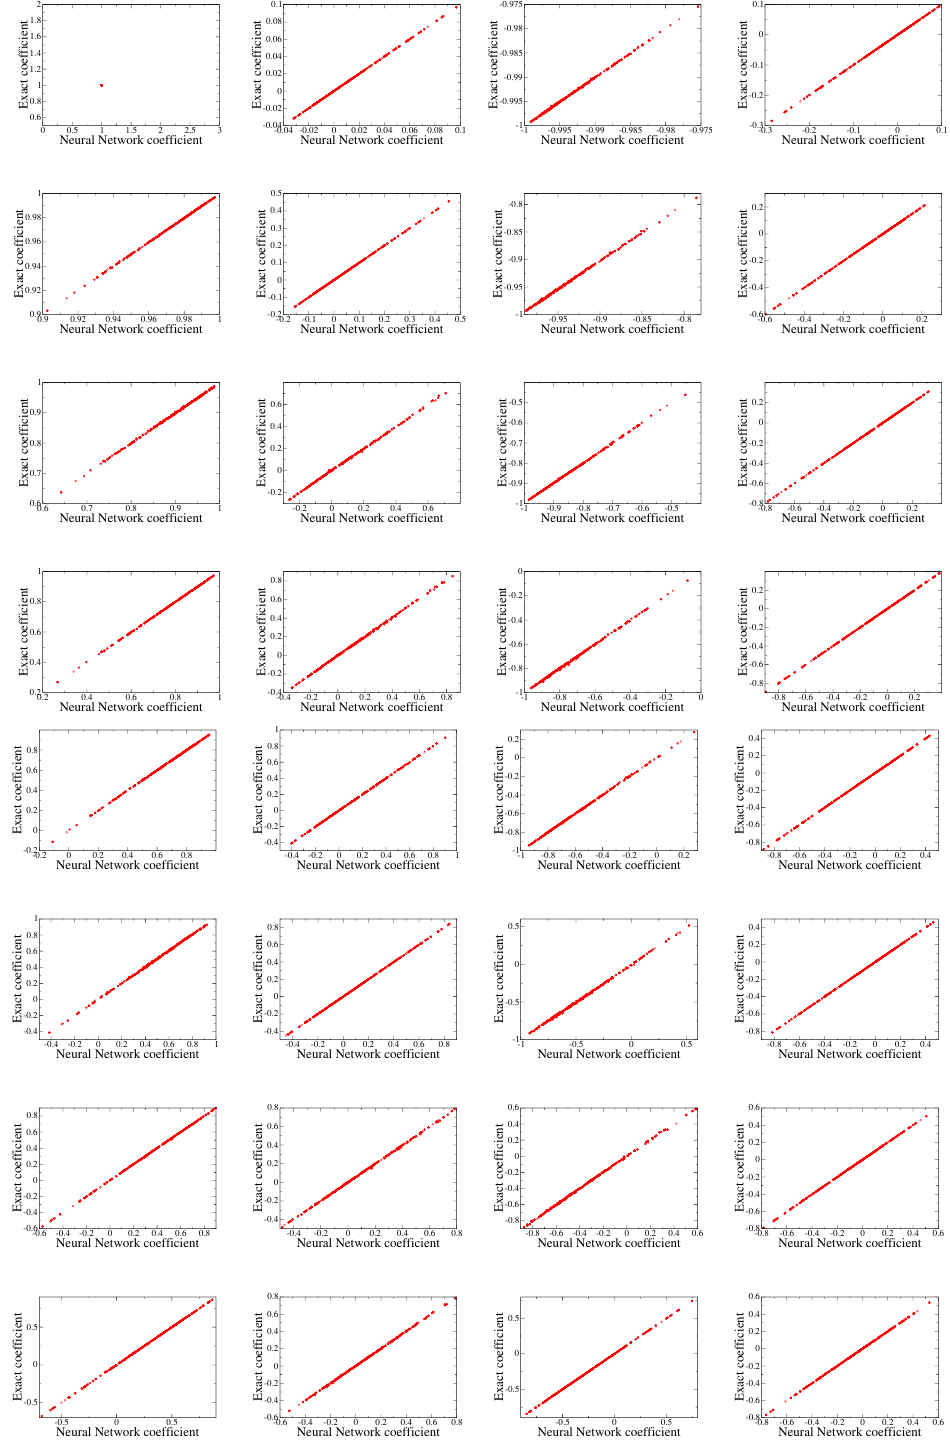
Figure 5. Comparison of the first 32 coefficients as computed by the KPM and the neural network method; 1000 samples are plotted in each figure. The figures are ordered from left to right and top to bottom from the order 0 − th to the order 31 −